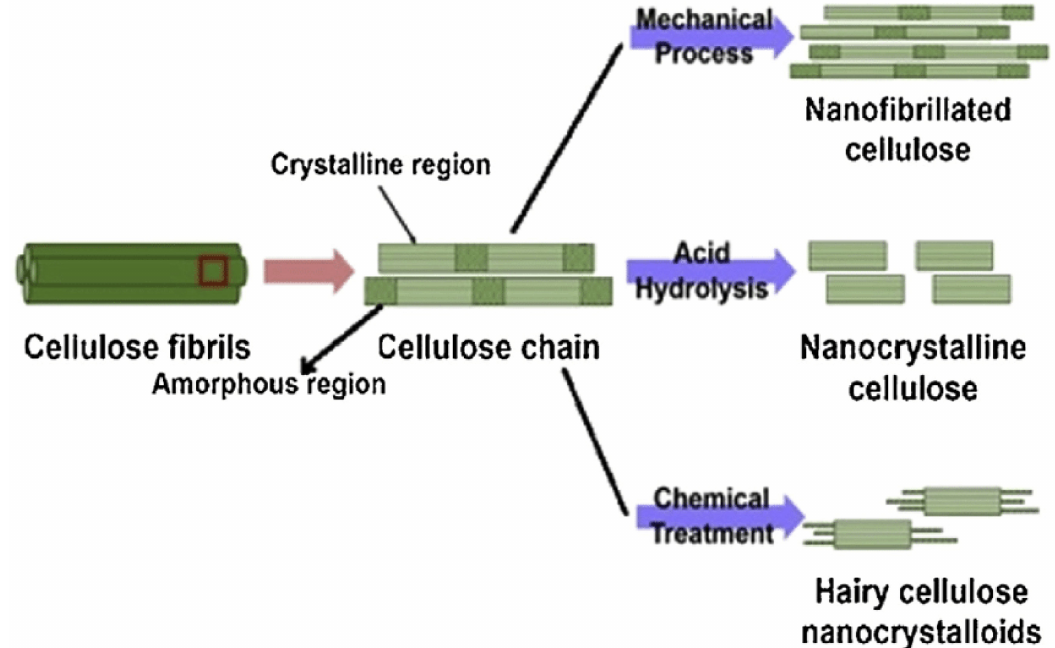
Figure 2. Extraction of nanocellulose from lignocellulosic biomass (reproduced with copyright permission from Sharma et al.